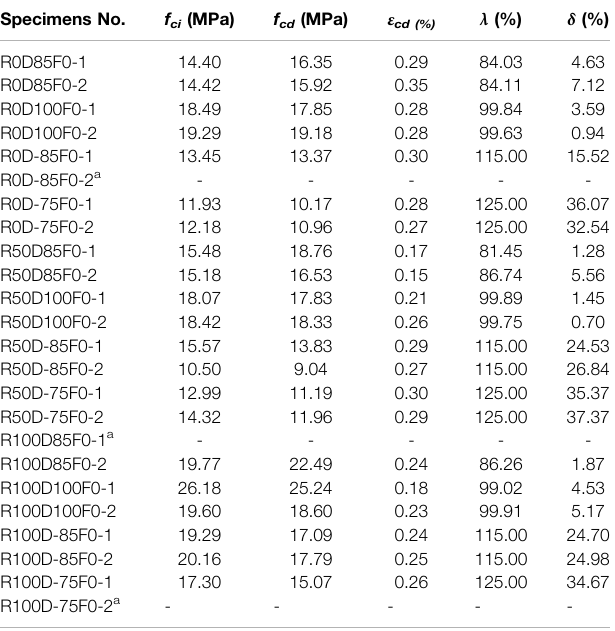
TABLE 6 | Test results of uncon fi ned specimens Specimens